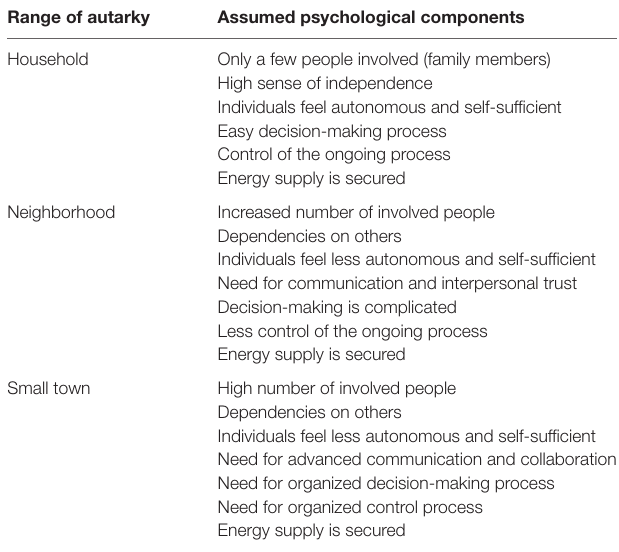
TaBle 1 | Assumed psychological components of the presented